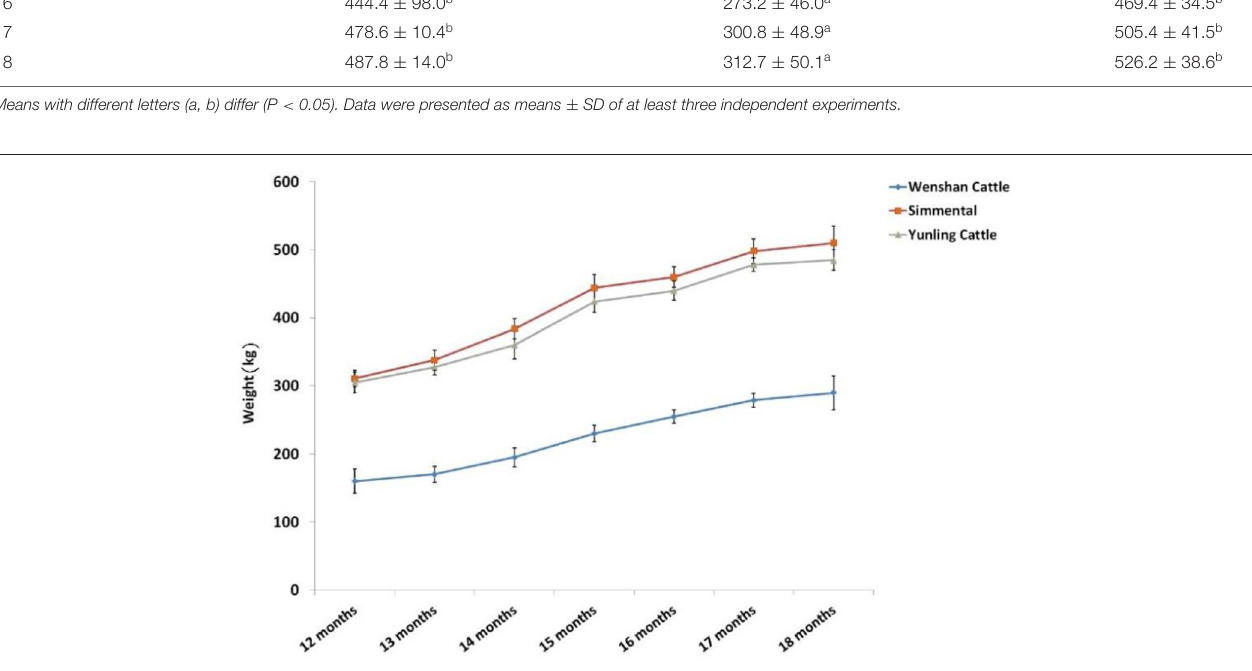
FIGURE 1 | Trend of body weight change at different growth periods in the three cattle breeds. Data were presented as means ± SD of at least three independent